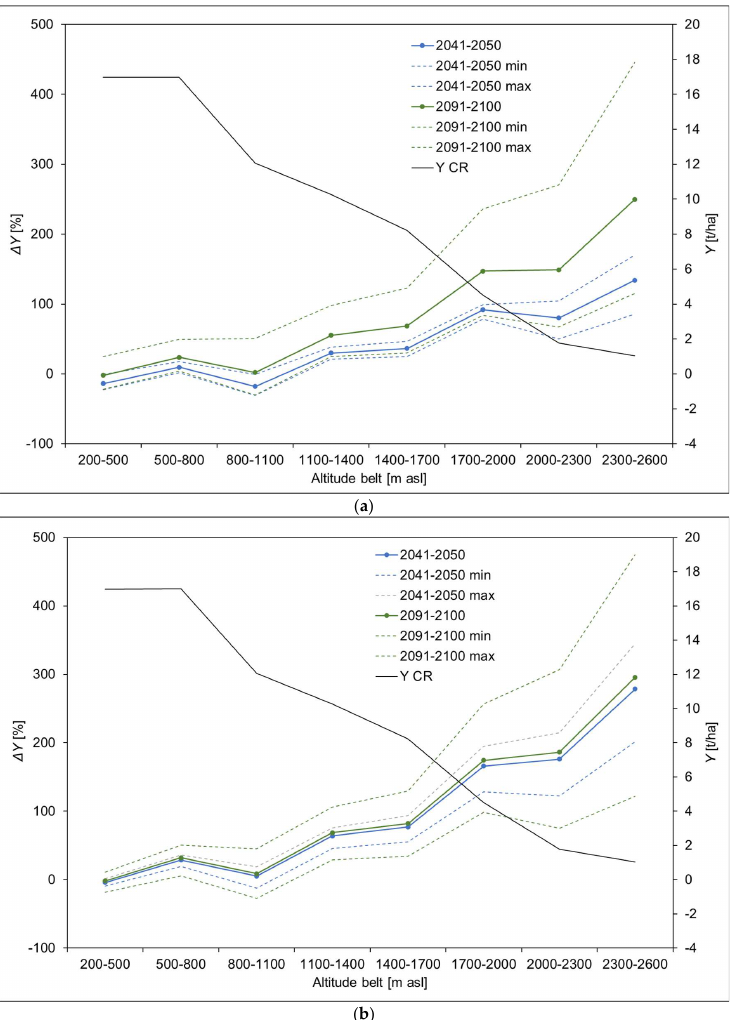
Figure 6. Percentage variation of specific production: percentage variation (mean, max, min, left ordinates axis) of specific production Y during 2041–2050 and 2091–2100, along with absolute values during the 2006–2017 (control run period, CR) for altitude belts ranging from 200–500 m asl to 2300–2600 m asl. ( a ) AR5, ( b ) AR6. Results above refer, respectively, to Trisetum flavescens below 2000 m asl and to Nardus stricta above 2000 m asl.